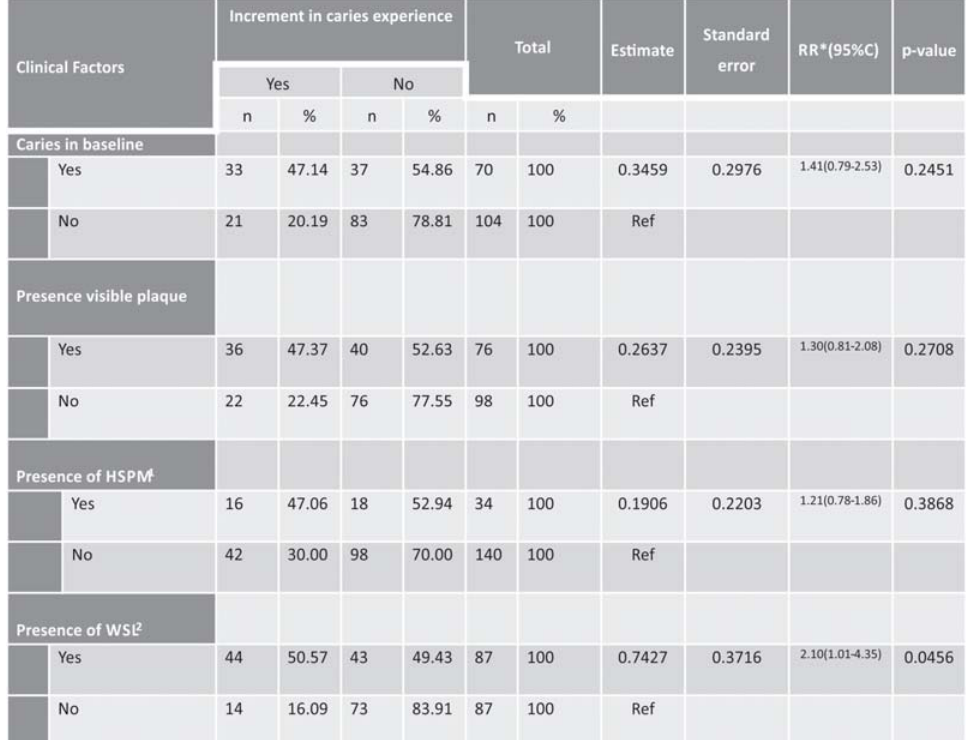
Table 3. Association between the children’s clinical variables and incidence of dental